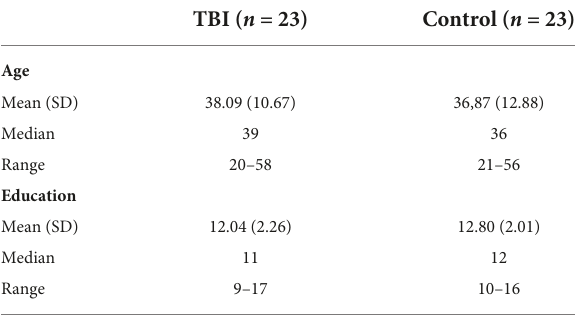
TABLE 2 Demographic information for all